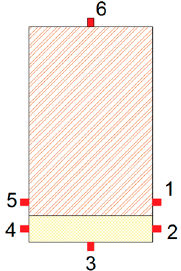
Figure 2. Location of the strain gauges along the mid-cross section of the reinforced beams.